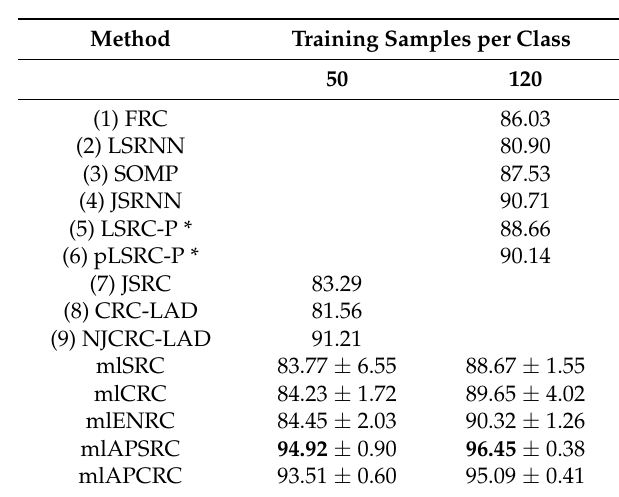
Table 10. Comparison of methods, denoted as mlSRC, mlCRC, mlENRC, mlAPSRC and mlAPCRC, with results reported in (1) [34], (2) to (4) [33], (5) to (6) [36] and (7) to (9) [28] for the University of Pavia image. The best OA results are marked in bold. FRC, fused representation-based classification; LSRNN, local sparse representation-based nearest neighbor classifier; SOMP, simultaneous orthogonal matching pursuit; JSRNN, joint sparse representation-based nearest neighbor classifier; LSRC-P, pixel-wise learning sparse representation classification with spatial co-occurrence probabilities estimated point-wise without any regularization (suffix-P) and the patch-based version, pLSRC-P; JSRC, joint sparse representation classification; CRC-LAD, collaborative representation classification with a locally-adaptive dictionary; NJCRC-LAD, nonlocal joint CR classification with a locally-adaptive